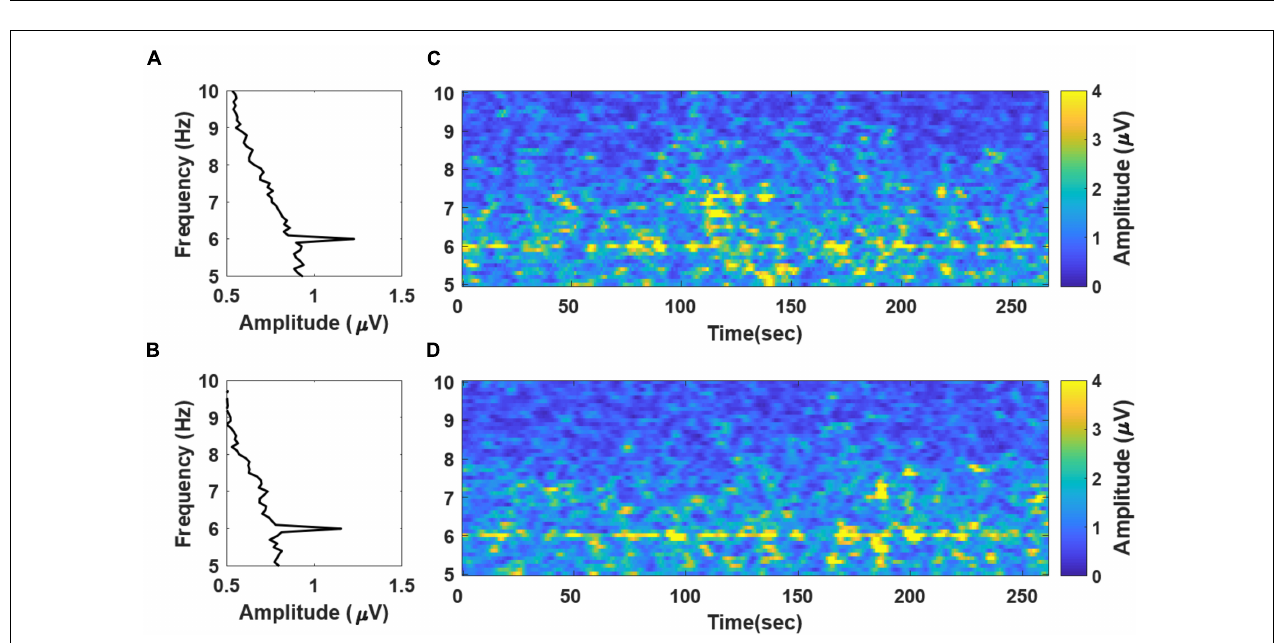
FIGURE 3 | Grand averaged frequency spectra and spectrograms evaluated with the EEG data recorded during (A) “fear” and (B) “nervous” movie screenings. A notable peak of SSVEP component is observed at 6 Hz. The spectrograms evaluated with 10 s moving window with 90% overlap of “fear” and “nervous” videos are presented in panels (C,D) , respectively. Please note that the frequency spectra in panels (A,B) are presented in a “90 ◦ -rotation” manner for matching with the y-axis in the spectrogram in the right panels (C,D) .